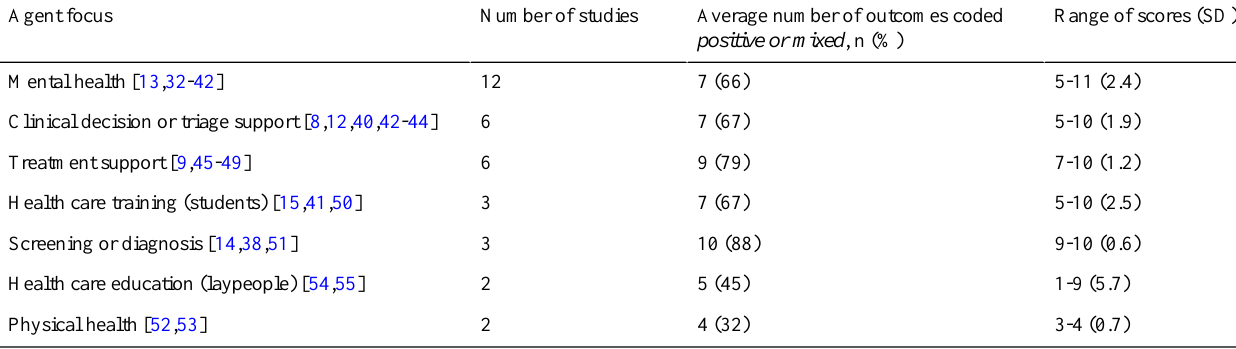
Table 3. Summary of evaluation outcomes by the area of health care addressed by the conversational agent a .